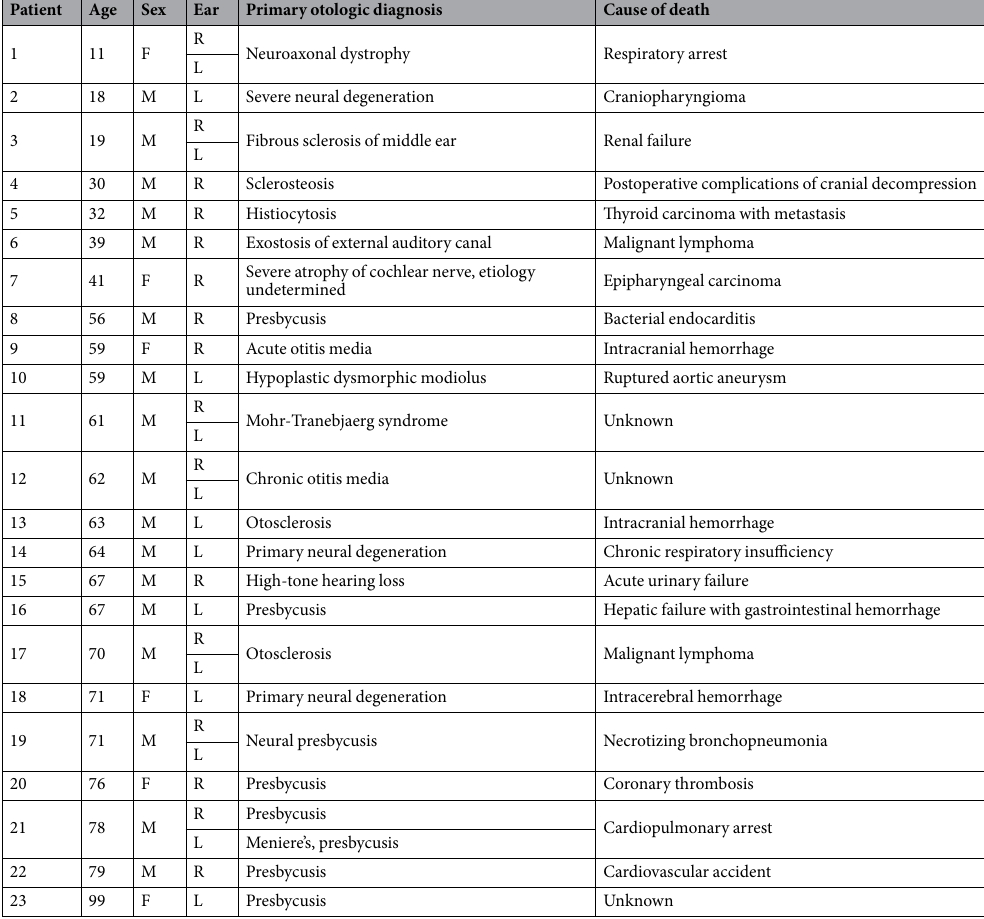
Table 1. Summary of clinical characteristics among patients with SGN counts greater than one standard deviation below the mean expected for age, despite a normal complement of sensory cells (n = 30 ears belonging to 23 patients). Patients listed from youngest to oldest. Sex, F(emale) or M(ale); ear: R(ight) or